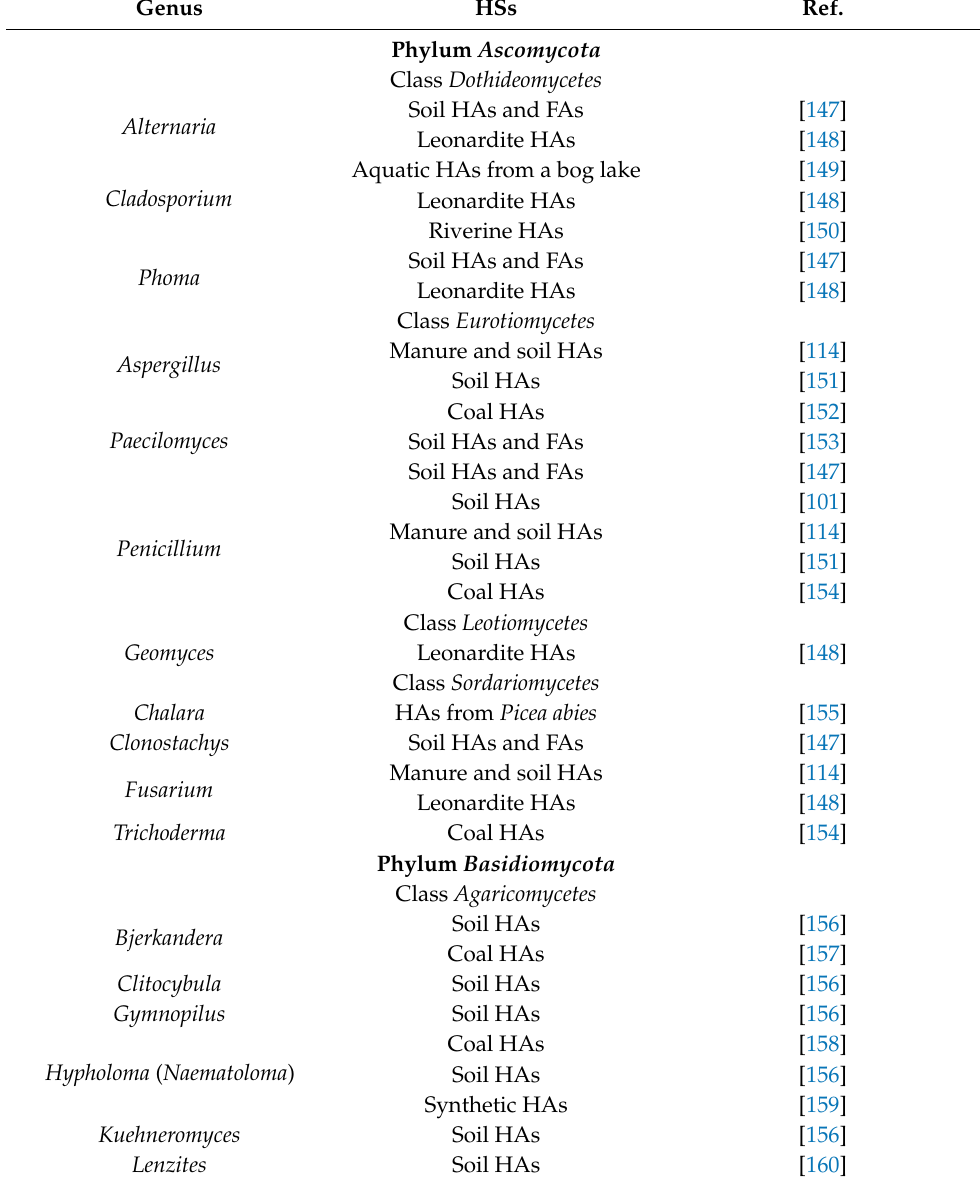
Table 3. Some genera of HS-degrading